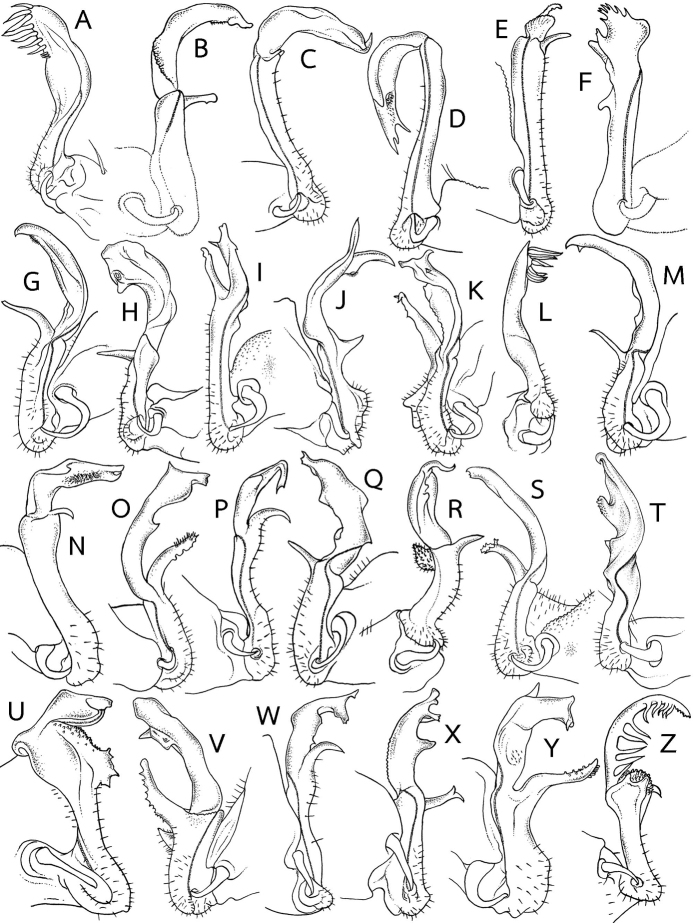

Gonopod
outline (mesal view of left and right gonopod) in several Eutrichodesmus species. A–N Gonopods of species with mid-dorsal projections on metaterga AE.
anisodentusBE.
asterCE.
asteroidesDE.
astriproximusEE.
astrisimilisFE.
cavernicolaGE.
deporatusHE.
dorsiangulatusIE.
lipsaeJE.
macclureiKE.
parasterLE.
pectinatidentisME.
steineri and NE.
subasteroidesO–Z Gonopods of species without mid-dorsal projections on metaterga OE.
apicalisPE.
arcicollarisQE.
armatocaudatusRE.
armatusSE.
basalisTE.
cambodiensis sp. nov. UE.
communicansVE.
curticornisWE.
demangeiXE.
digitatusYE.
distinctus and ZE.
elegans. Not to scale. Figures modified from A, L Zhang (1995) B, C, V, YGolovatch et al. (2009b)D, E, NGolovatch et al. (2016)FSinclair (1901)G, K, MLiu and Wesener (2017)H, P Zhang in Zhang and Wang (1993)I, OGolovatch et al. (2015)J Hoffman (1977) Q, S, UGolovatch et al. (2009a)RMiyosi (1951)WSilvestri (1910)XLiu and Tian (2013) and ZMiyosi (1951).